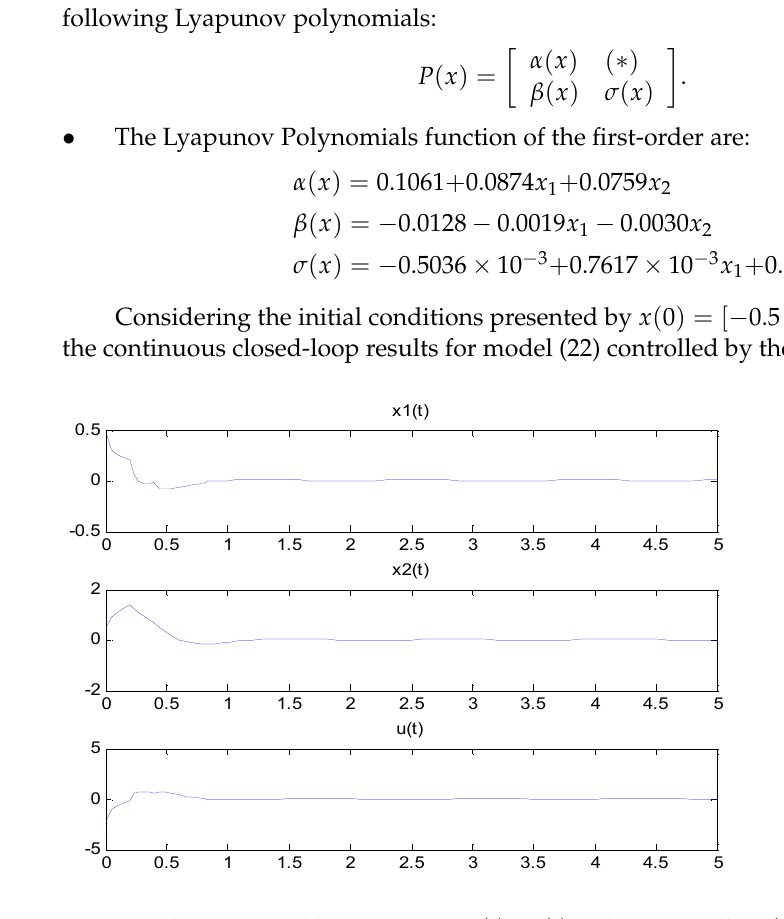
Figure 9. The state variables evolutions x 1 ( t ) , x 2 ( t ) and the controller u ( t )